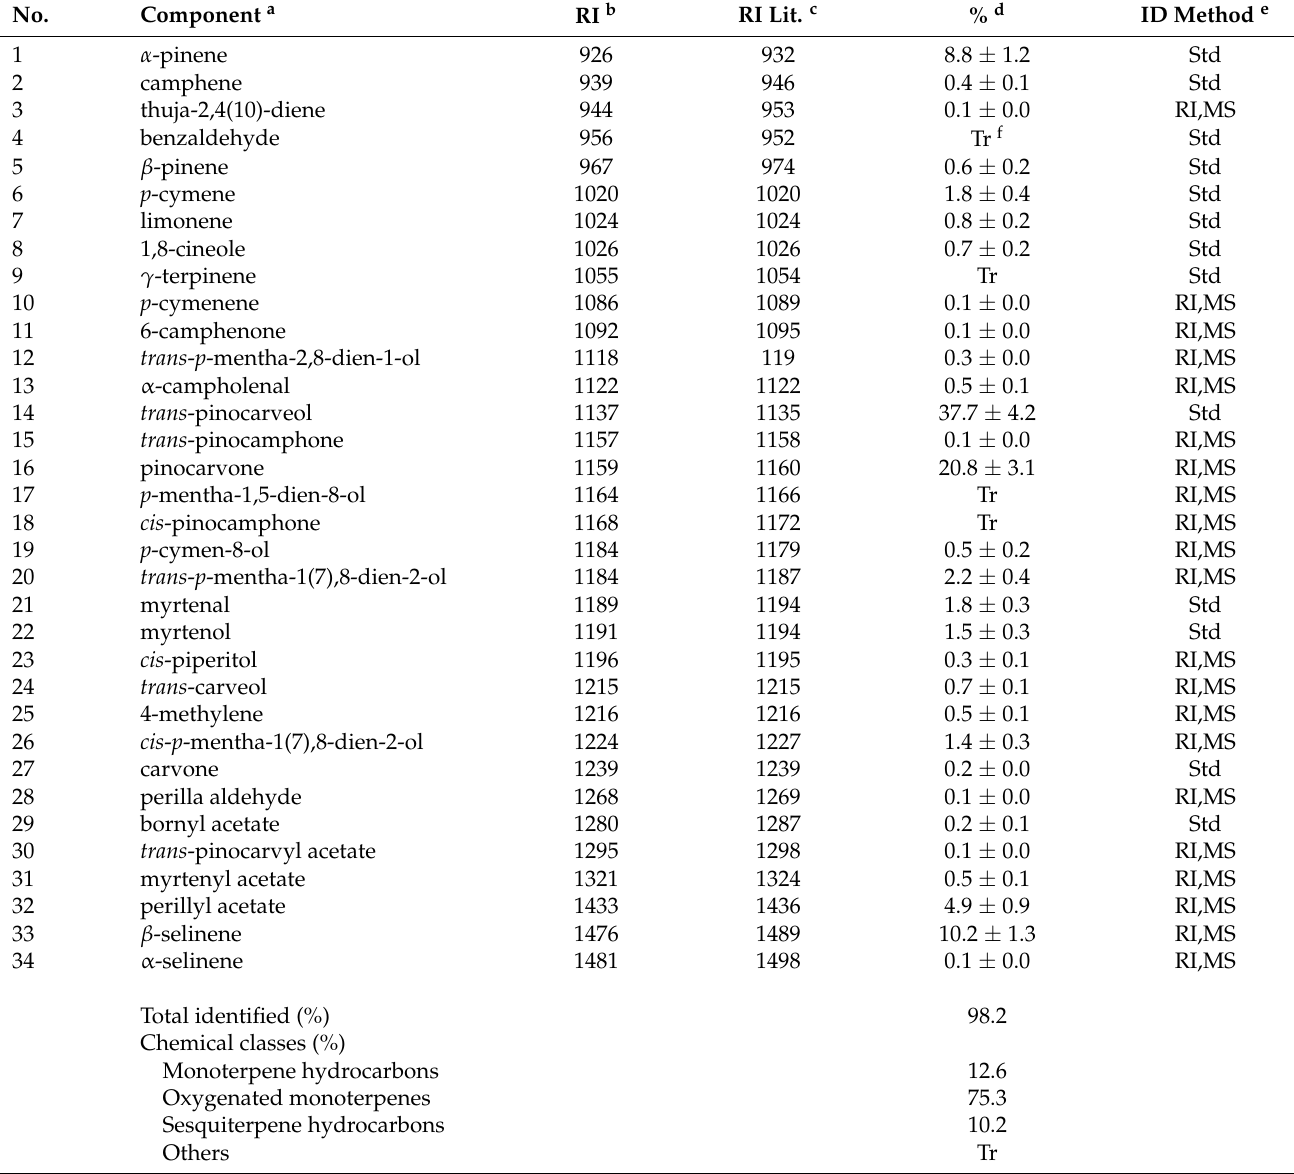
Table 1. Chemical composition of the Myrothamnus moschatus essential